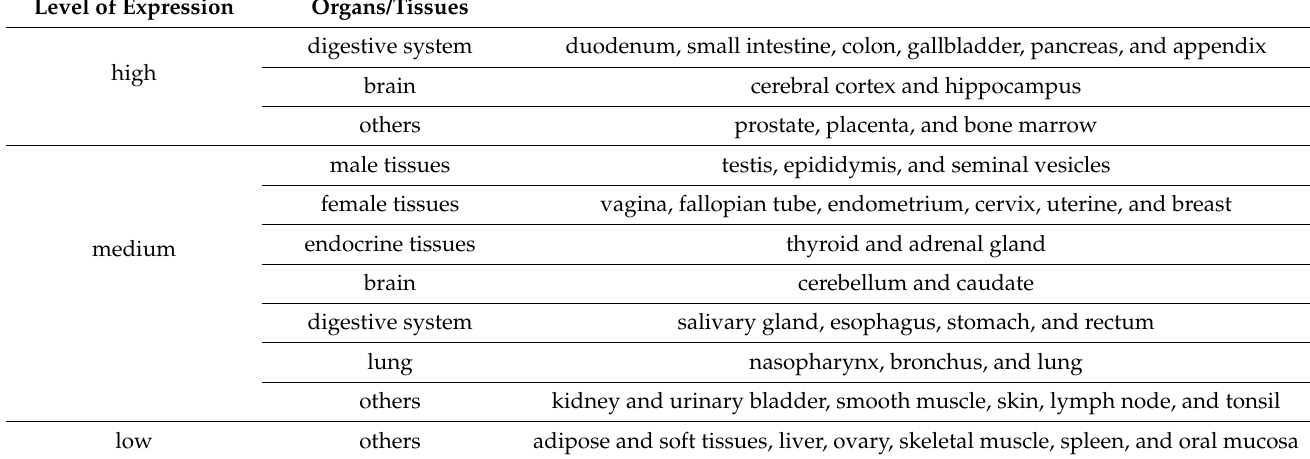
Table A1. Expression level of ACBD3 protein in different organs and tissues according to The Human Protein Atlas (available on 28 May 2021 at